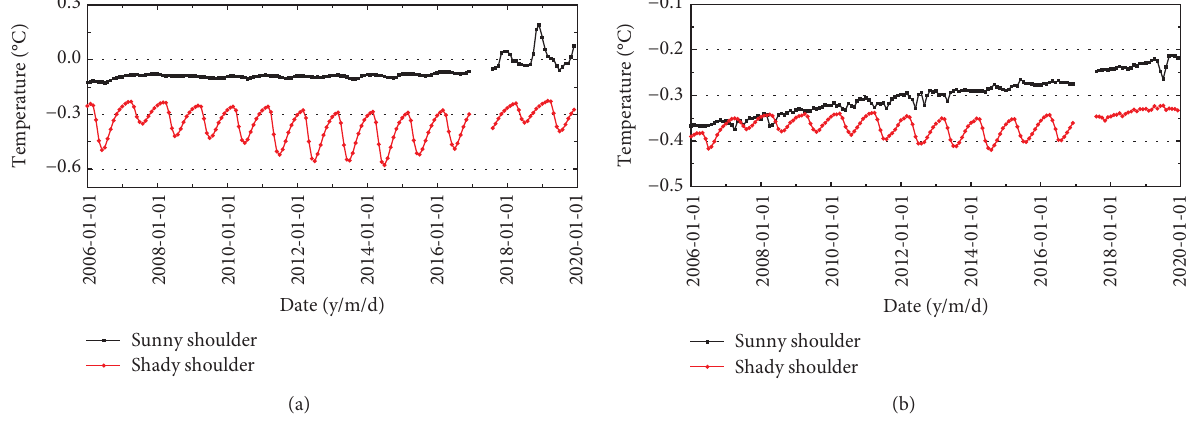
Figure 6: Variation of ground temperature at 8 m (a) and 12m (b) on the sunny and shady sides of